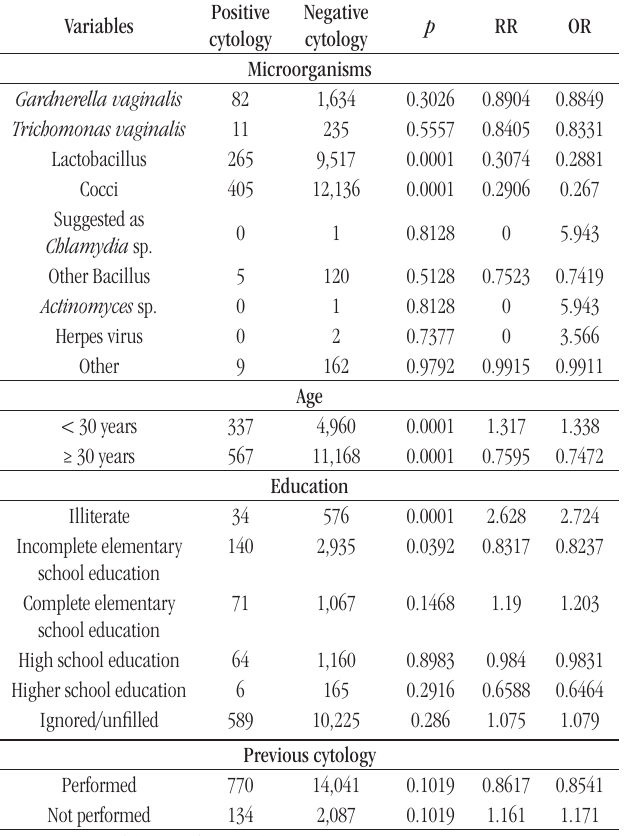
taBLE 2 − Profile of women with cervical changes from the municipality of Caruaru, Pernambuco,